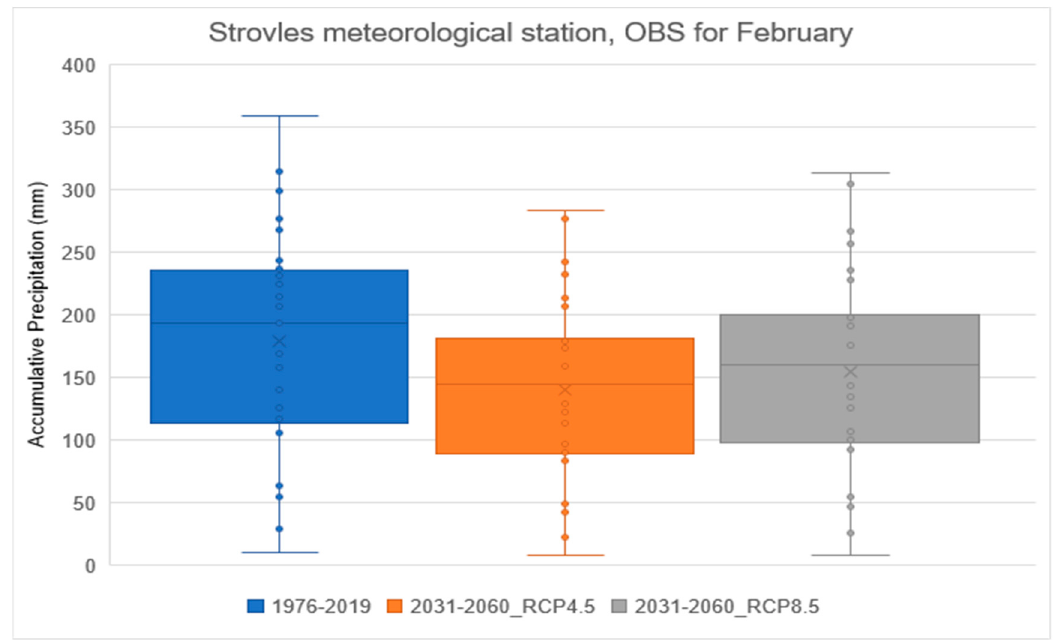
Figure 12. February precipitation data for 2031–2060 according to OBS, RCP4.5, and RCP8.5 at the Strovles meteorological station.